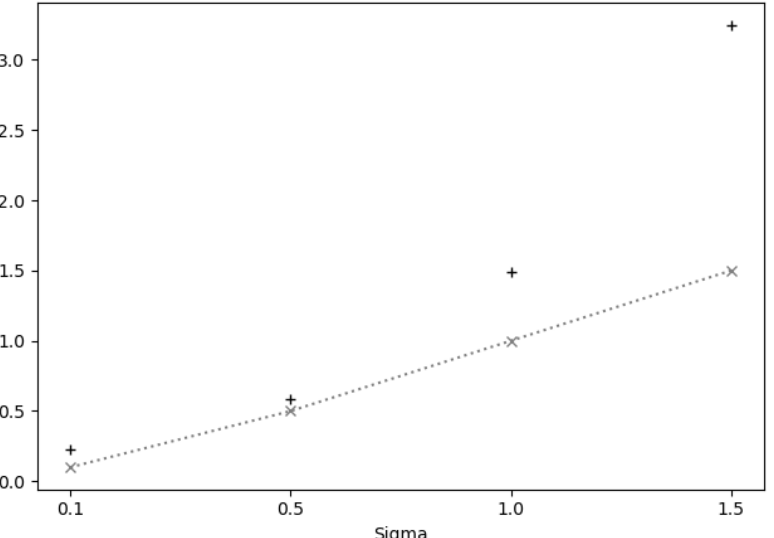
Figure 4. Average of the estimates ˆ σ (“+” symbol) for different levels of standard deviations σ in { 0.1,0.5,1.0,1.5 } used in the simulation of the 100 series. The true value is represented by the “x”